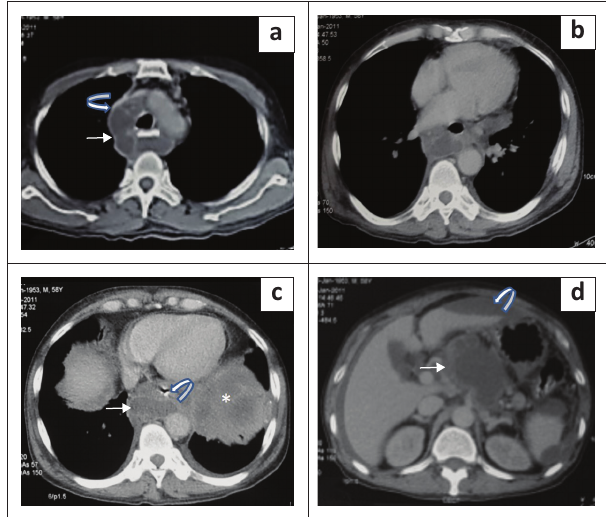
FIGURE 3: Axial sections of contrast-enhanced CT scan of the chest and abdomen (a–d) show the pseudocyst in the visceral compartment of the mediastinum abutting the superior vena cava (curved arrow in a) and descending thoracic aorta, with anterior displacement of the oesophagus (curved arrow in c). It is extending into the abdomen through the oesophageal hiatus (white arrow in c) where it is seen arising from the body of pancreas (white arrow in d). Ascites (curved arrow in d), bilateral pleural effusions and left lower lobe consolidation (asterisk in c) are also